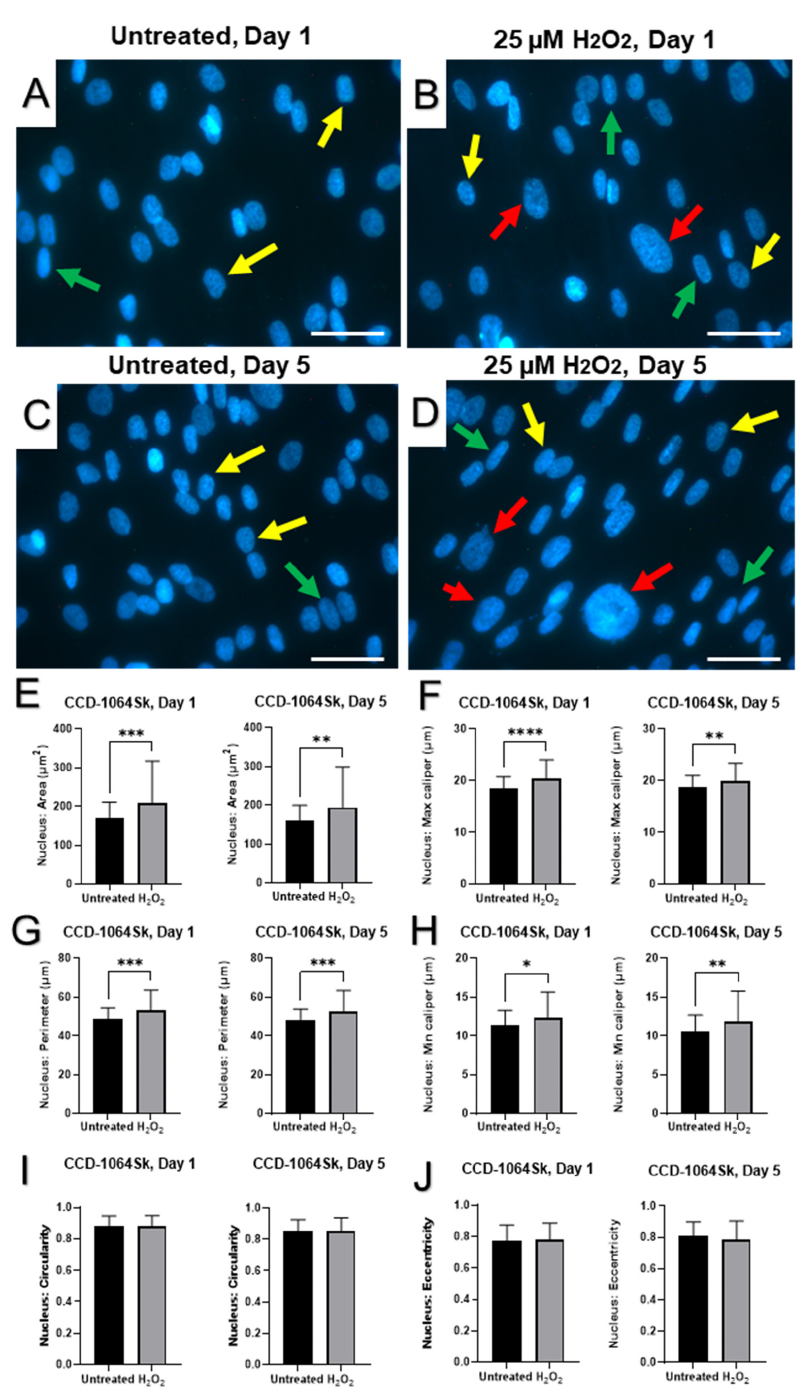
Figure 4. DAPI-stained nuclei of dermal fibroblasts (CCD-1064Sk), p.11 (one-step model). Pictures A-D represent nuclear changes observed by immunofluorescence microscopy on days 1 and 5 after a single 25 µ M H 2 O 2 exposure. Arrows point to nuclei with specific nuclear shapes: yellow—round, green—elongated, and red—gigantic/irregular. ( A ) Untreated cells on day 1; ( B ) prematurely aged fibroblasts after 25 µ M of H 2 O 2 exposure on day 1; ( C ) untreated cells on day 5; ( D ) senescent fibroblasts on day 5. Nuclear parameters measured utilizing QuPath in each sample: ( E ) Nuclear area; ( F ) Nuclear max caliper; ( G ) Nuclear perimeter; ( H ) Nuclear min caliper; ( I ) Nuclear Circularity; ( J ) Nuclear eccentricity. Data were analyzed with a Student’s unpaired t -test for each separate parameter. Significance is indicated within the figures using the following scale, * p < 0.05; **, p < 0.01; ***, p < 0.001; ****, p < 0.0001. Bars represent mean ± SD. Scale bars = 20 µ